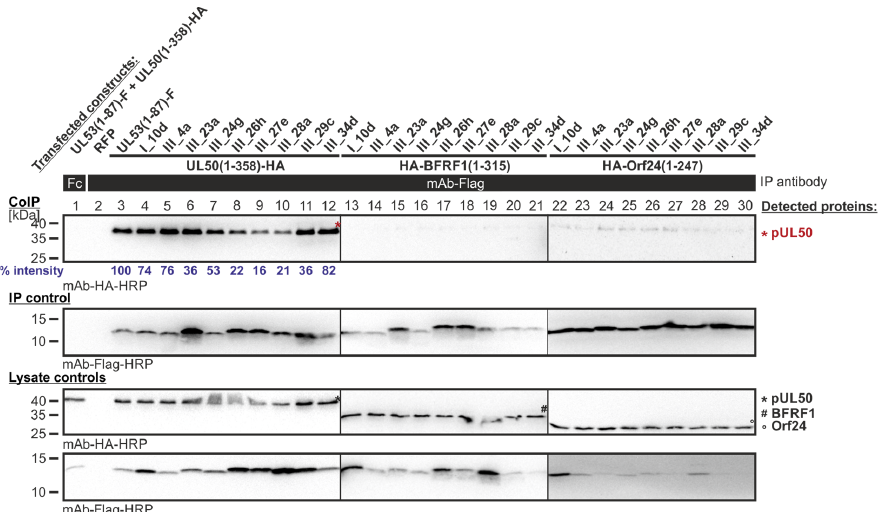
Figure 7. CoIP ‐ based interaction analysis of HCMV pUL50, EBV BFRF1 and VZV Orf24 with the library clones that exerted shared ‐ hook binding activity in the primary screening of Lib1 with library clones that exerted shared-hook binding activity in the primary screening of Lib1 with pUL50.